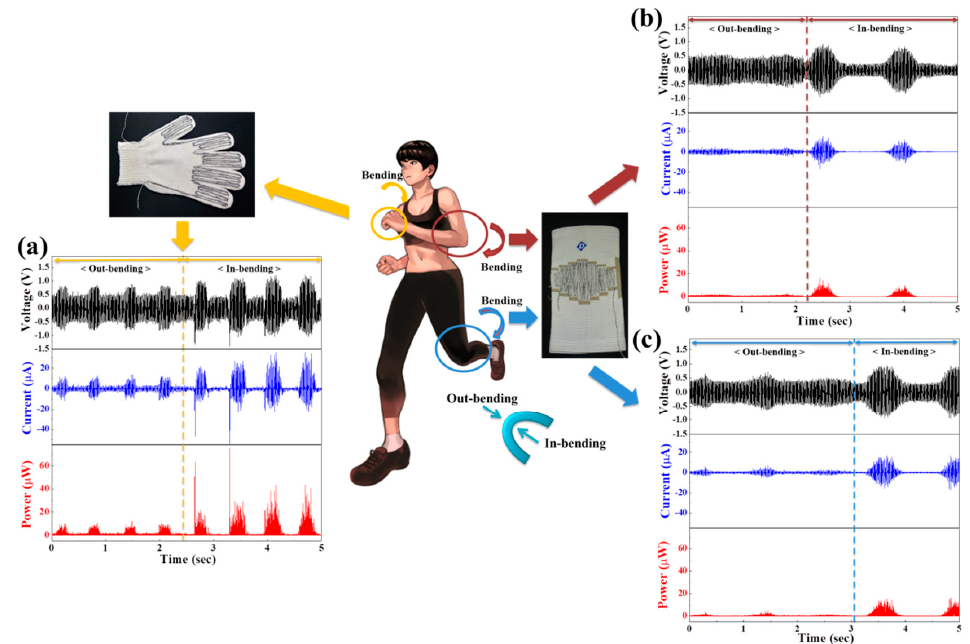
Figure 4. ( a ) Output voltages, output currents, and output powers according to in-bending and out-bending finger movements as a cotton glove stitched in the finger parts with the core-shell piezoelectric yarns is worn, and output voltages, output currents, and output powers according to in-bending and out-bending ( b ) elbow and ( c ) knee movements as the guard stitched in the elbow and knee parts by the core-shell piezoelectric yarns is worn, respectively.